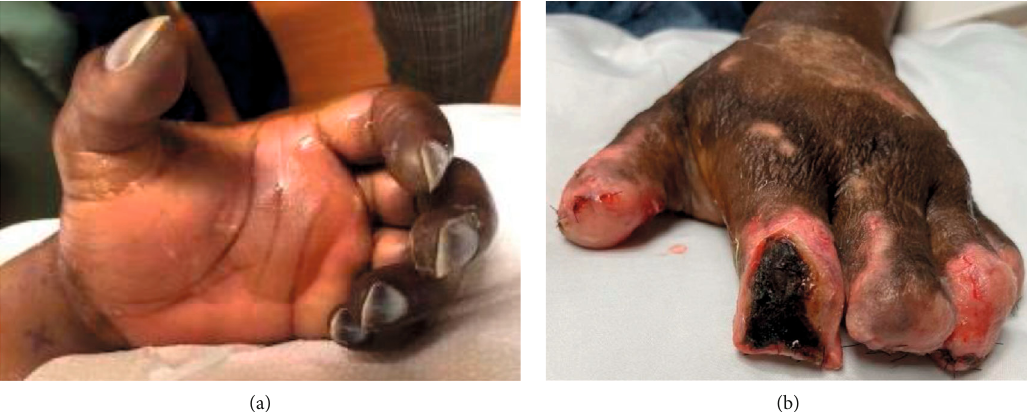
Figure 1: (a) The left-hand ischemia with dry gangrene of all the fi ve digits. Also noted is the bulla on the palmar aspect of the left hand. The dorsum aspect (not shown in this fi gure) also had a large bulla. (b) The left hand one week postamputation of all fi ve